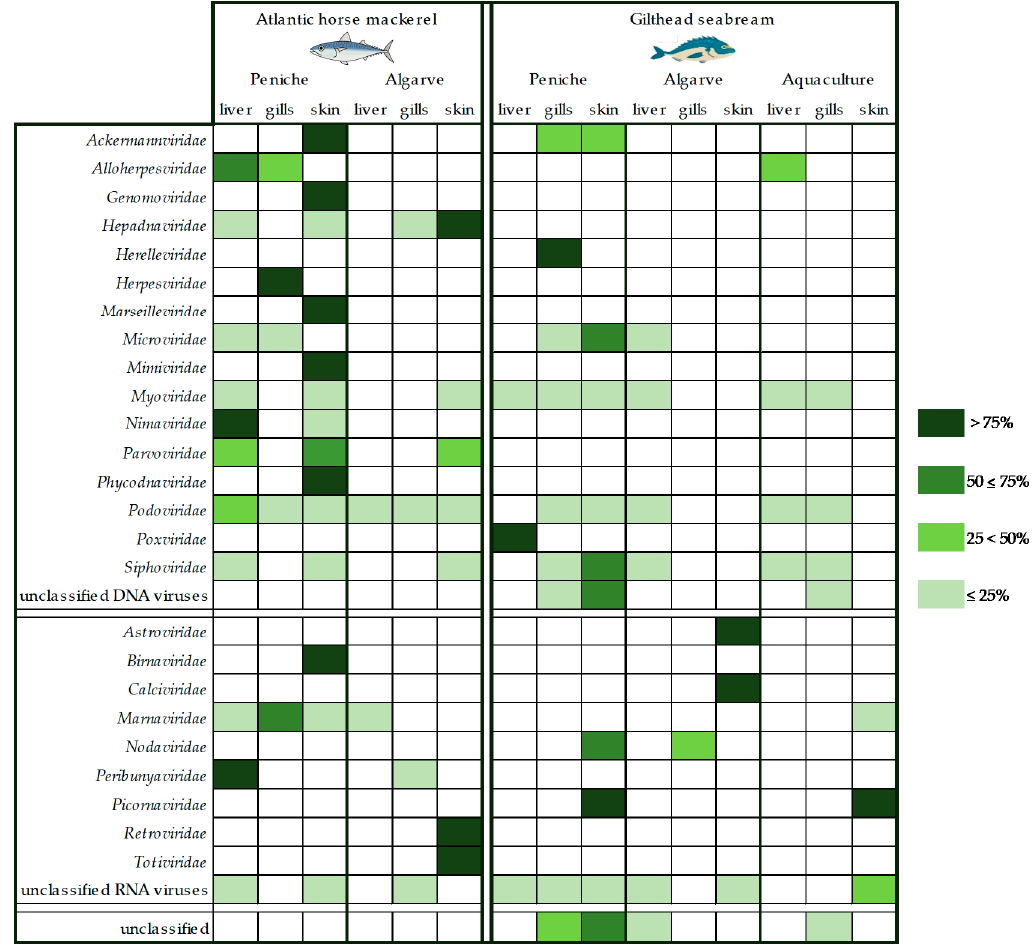
Figure 3. Viral abundance for each fish species, region, and tissue type normalized for each viral family (the taxonomic classification used is based on the Taxonomy Database from NCBI).